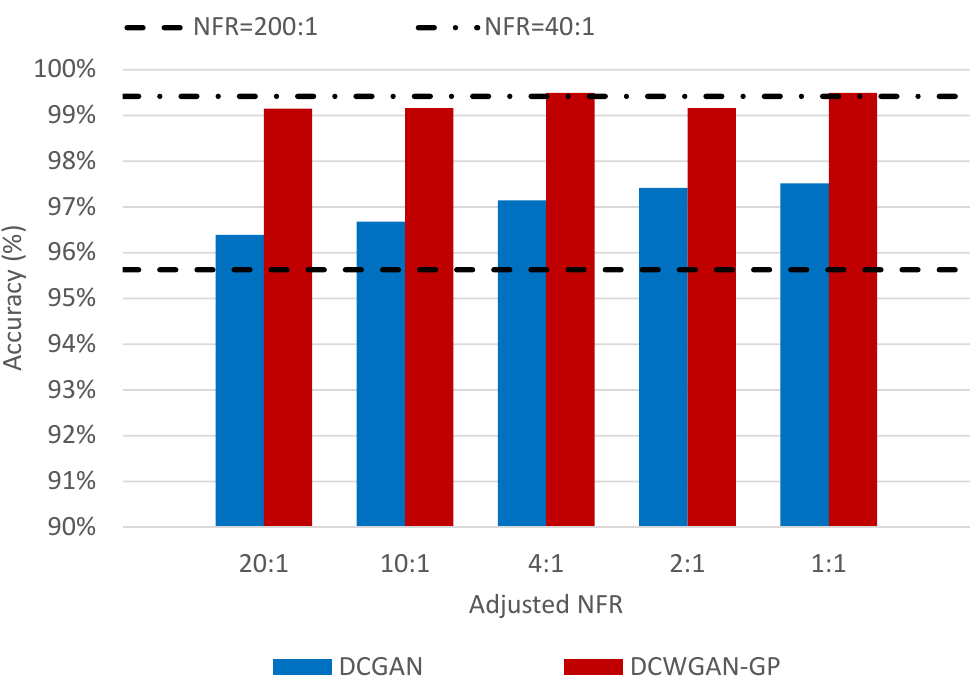
Figure 17. FDD accuracy testing:NFR = 200:1 with 20,000 normal